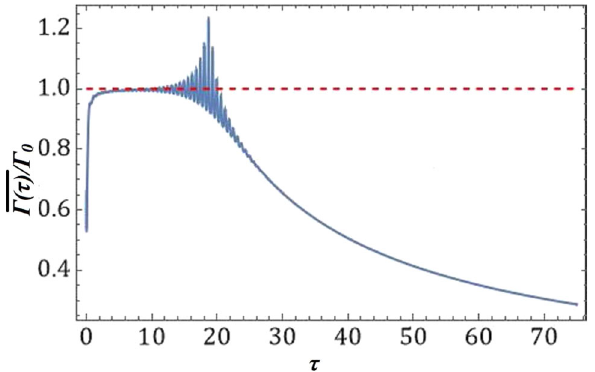
(cid:4) t Γ (ς) d ς obtained for 0 t τ = ¯ h 0 τ 0 , Γ 0 is the